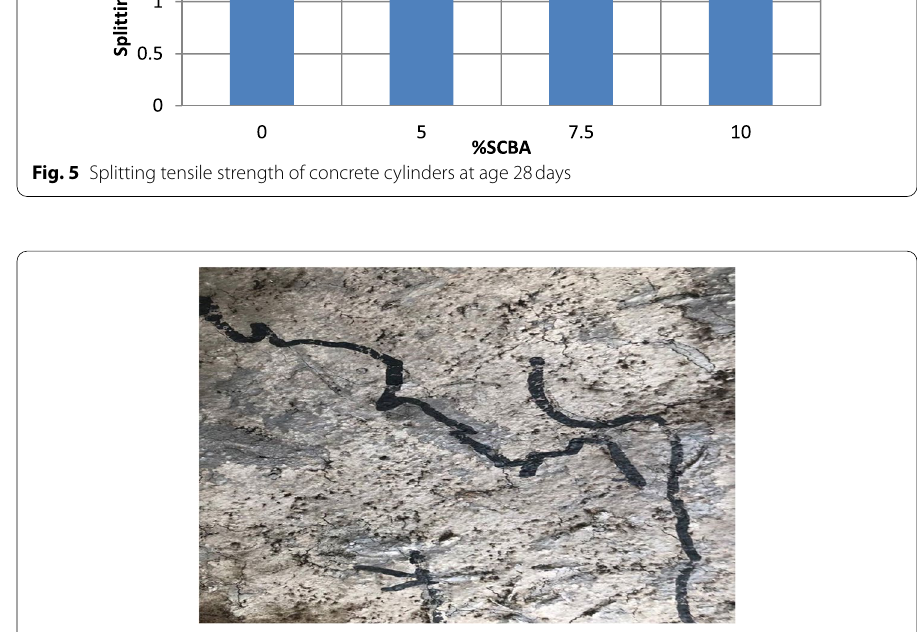
Fig. 6 Slab with